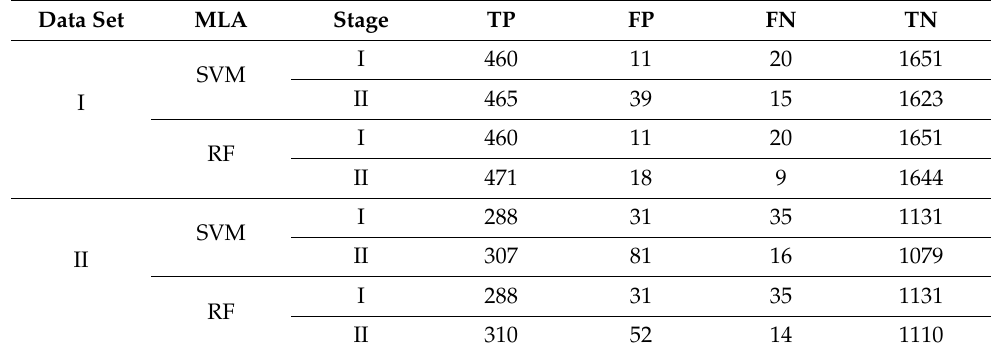
Table 5. Quantitative results of each stage of the two-step classifier.